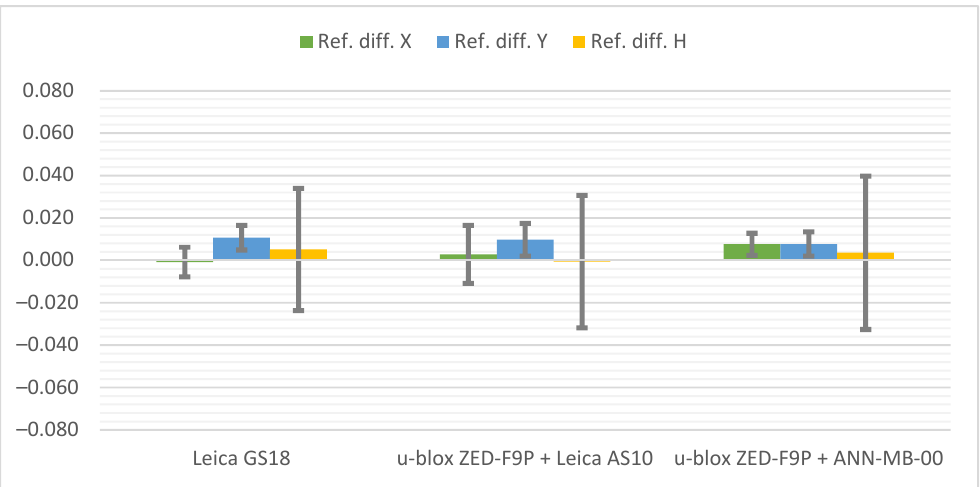
Figure 9. Cumulated diagrams with results of measurements at the Pt 4 station (obscured horizon from the north; differences in relation to the reference points with standard deviations [m]).